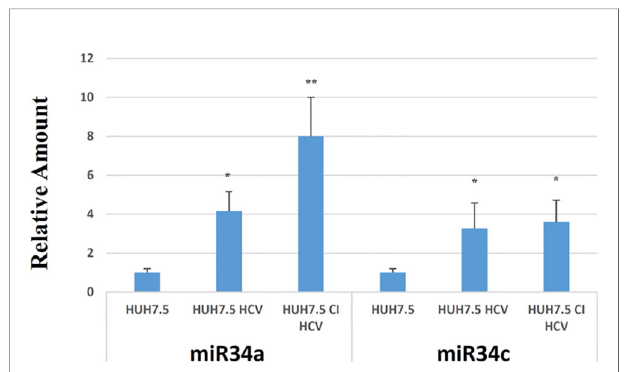
FIGURE 1 | RT-PCR analysis for miR34a and miR34c in empty Huh7.5 (control), HCV infected and Huh7.5 CI. Values are expressed as fold change vs. the control. Data are representative of experiments performed in triplicate on three different samples (p value * ≤ 0.05, ** ≤